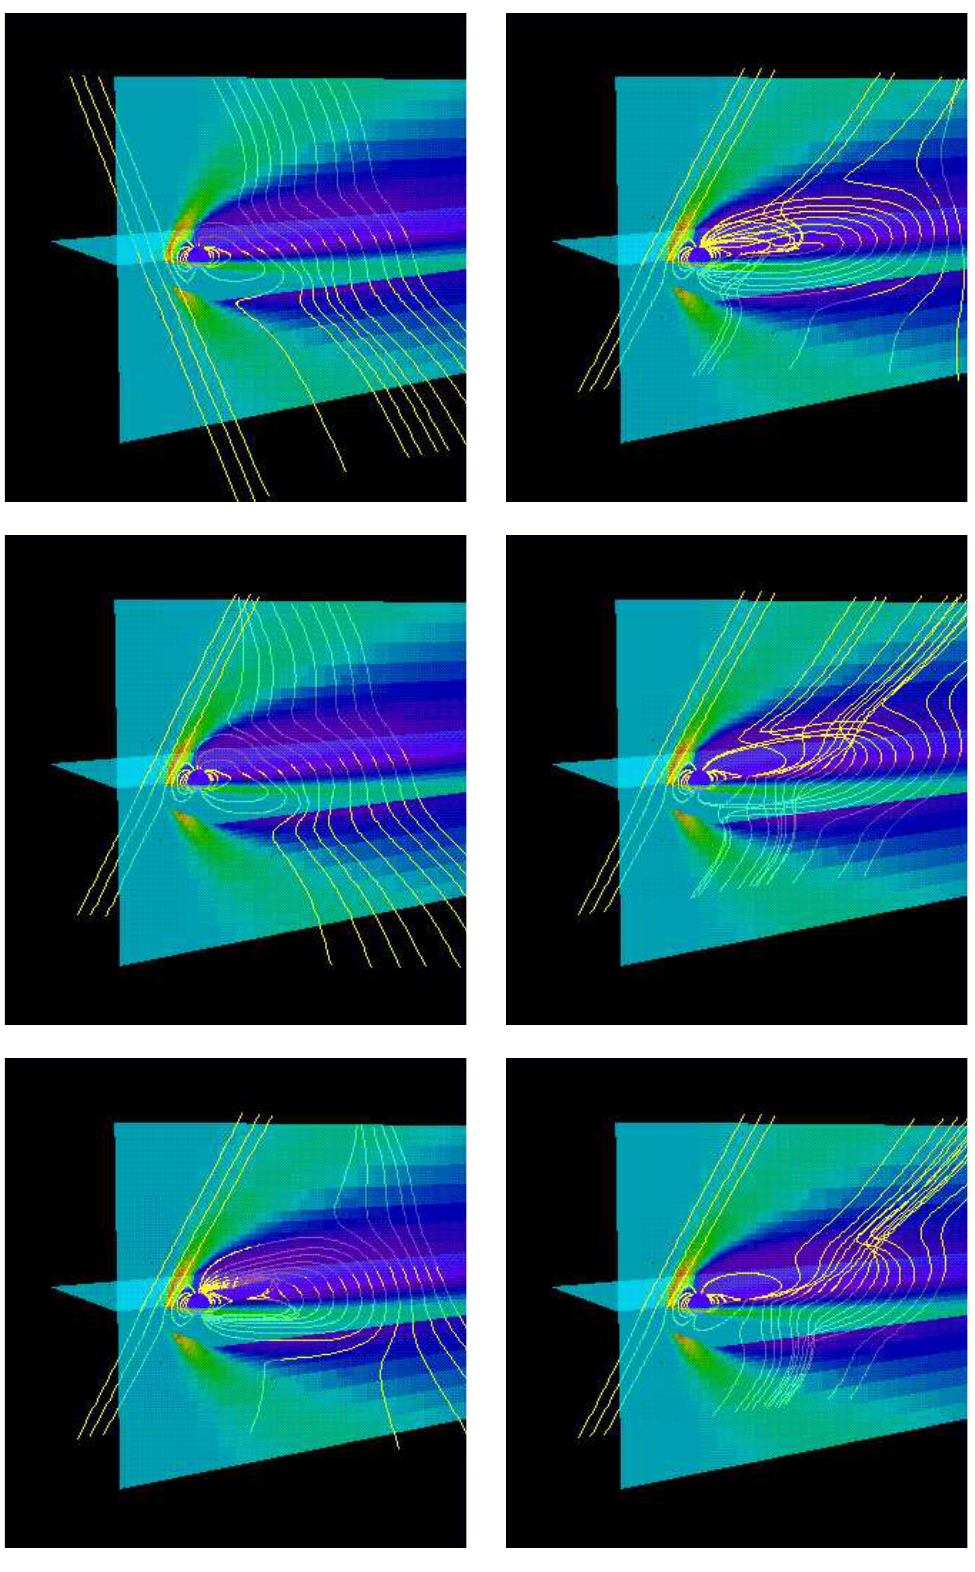
Fig. 8. A 3-D view on field lines crossing the x -axis for the fast IMF B y sign change case (run 2a). The plots show the state of the magnetosphere − 8, 7, 22min (first column from top to bottom) and 37 , 52 , 57min (second column, from top to bottom) after the center of the IMF B y sign-change region ( B y = 0) has passed the dayside